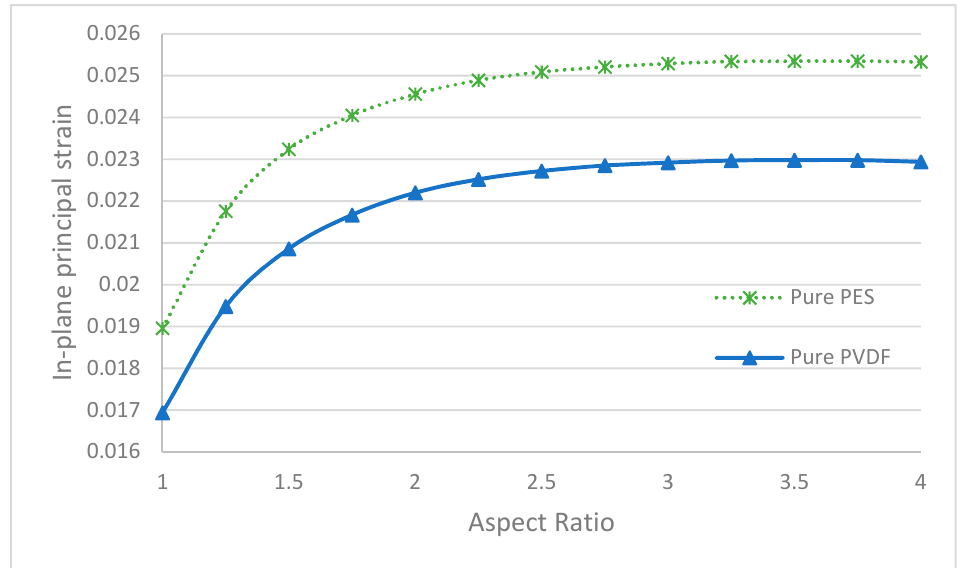
Figure 16. The maximum in-plane principal strain of pure membranes with different aspect ratios.